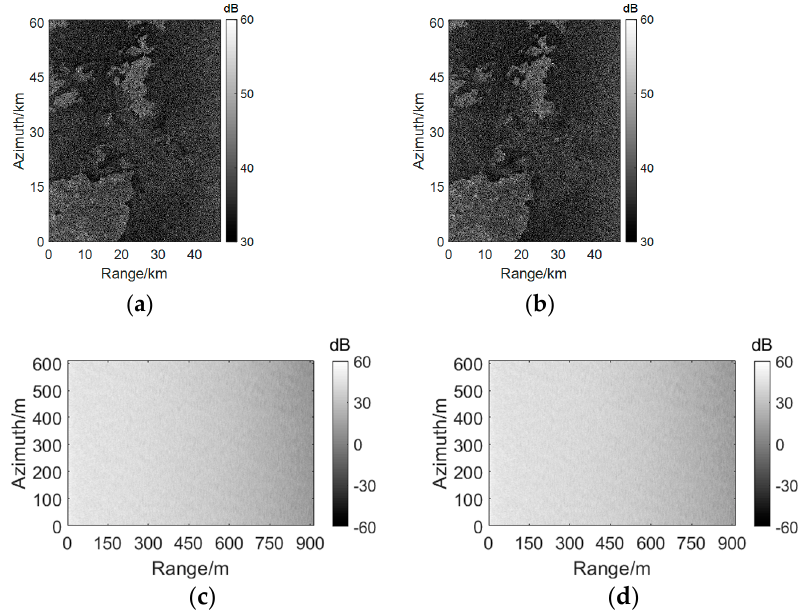
Figure 3. ( a ) The intensity of the master image corresponding to TerraSAR-X; ( b ) the intensity of the slave image corresponding to TanDEM-X; ( c ) the intensity of the master image corresponding to M920; ( d ) the intensity of the slave image corresponding to M920. Table 1. SAR image parameters of the TerraSAR-X and TanDEM-X satellites and airborne IRA.